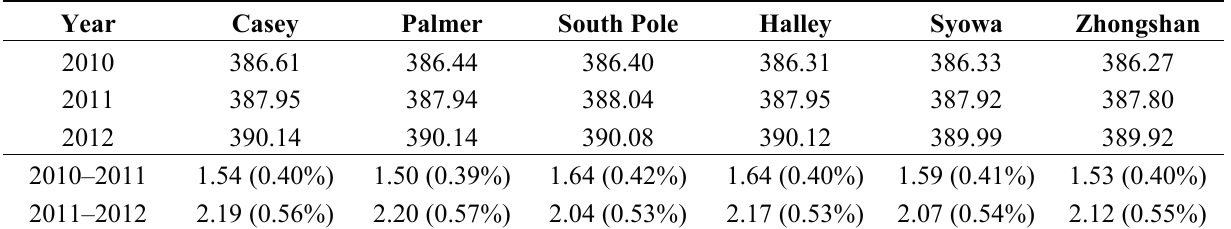
Table 2. Average annual CO station